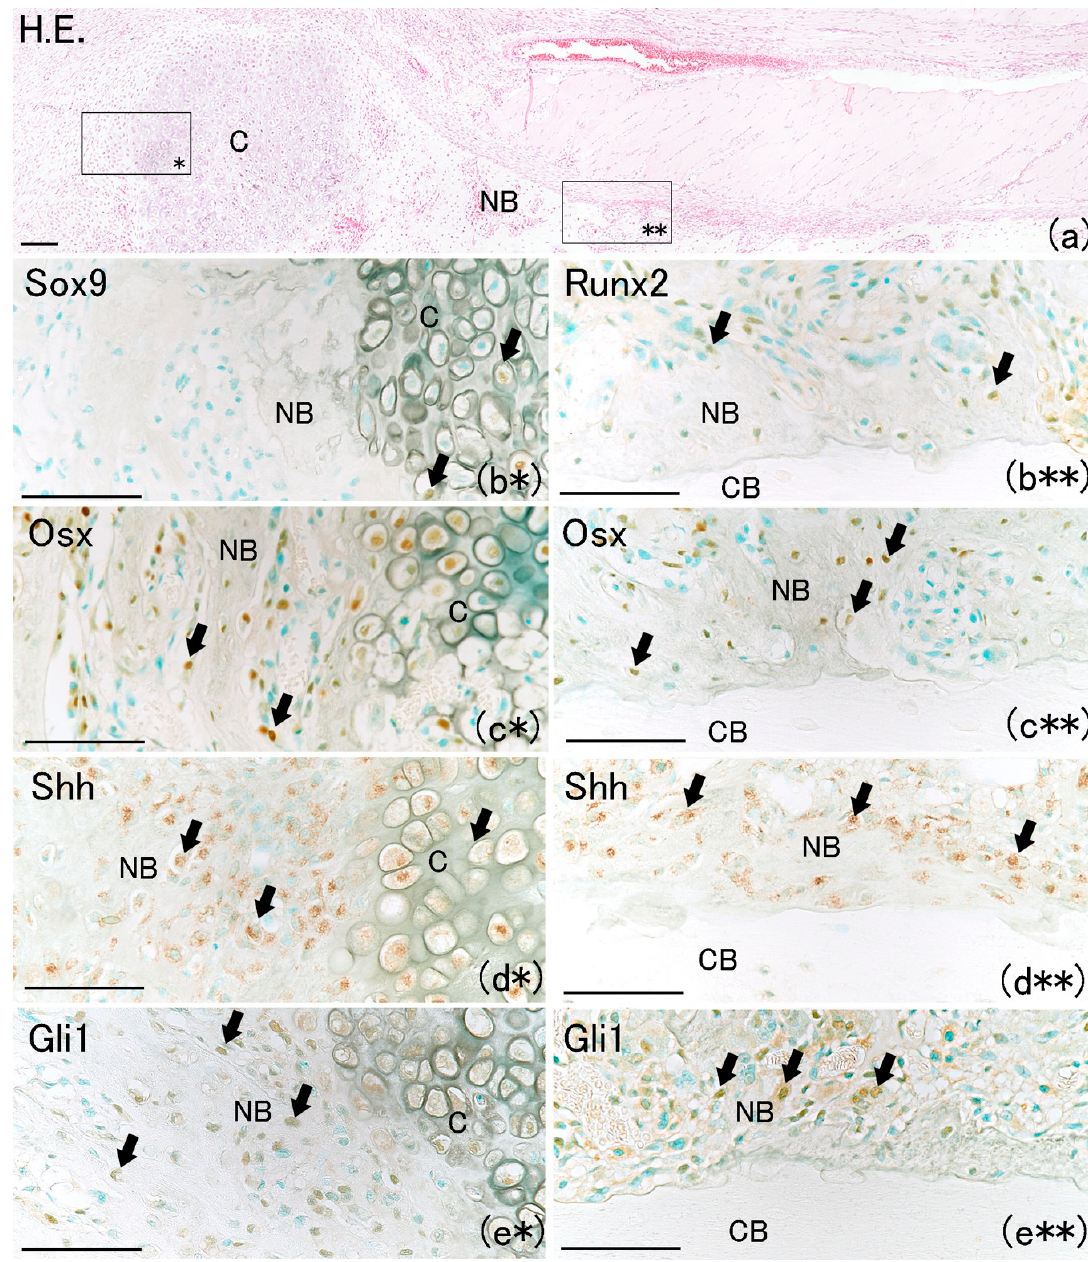
Figure 6. Newly formed cartilage and bone matrix were observed in the fracture site. ( a ) Newly formed cartilage matrix was observed in fracture site at day 7 on rat lib bone fracture. Scale bar: 100 μ m. ( b* ) Sox9-positive cells were observed in chondrocyte but not on the cell surface of bone matrix. Scale bar: 50 μ m. ( c* ) Osx-positive cells were observed at the surface of newly formed bone matrix and in chondrocyte (arrows). Scale bar: 50 μ m. ( d* ) Shh-positive expression was also around the new cartilage matrix (arrows). Scale bar: 50 μ m. ( e* ) Gli1-positive cells were also around the new cartilage matrix (arrows). Scale bar: 50 μ m. ( b** ) Runx2-positive cells at the surface of new bone but in the existing bone (arrows). Scale bar: 50 μ m. ( c** ) Osx-positive cells at the surface of new bone but in the existing bone (arrows). Scale bar: 50 μ m; ( d** ) Shh-positive expression at the surface of new bone but in the existing bone (arrows). Scale bar: 50 μ m. ( e** ) Gli1-positive cells at the surface of new bone but in the existing bone (arrows). Scale bar: 50 μ m. (CB: cortical bone; NB: newly formed bone; C: cartilage).